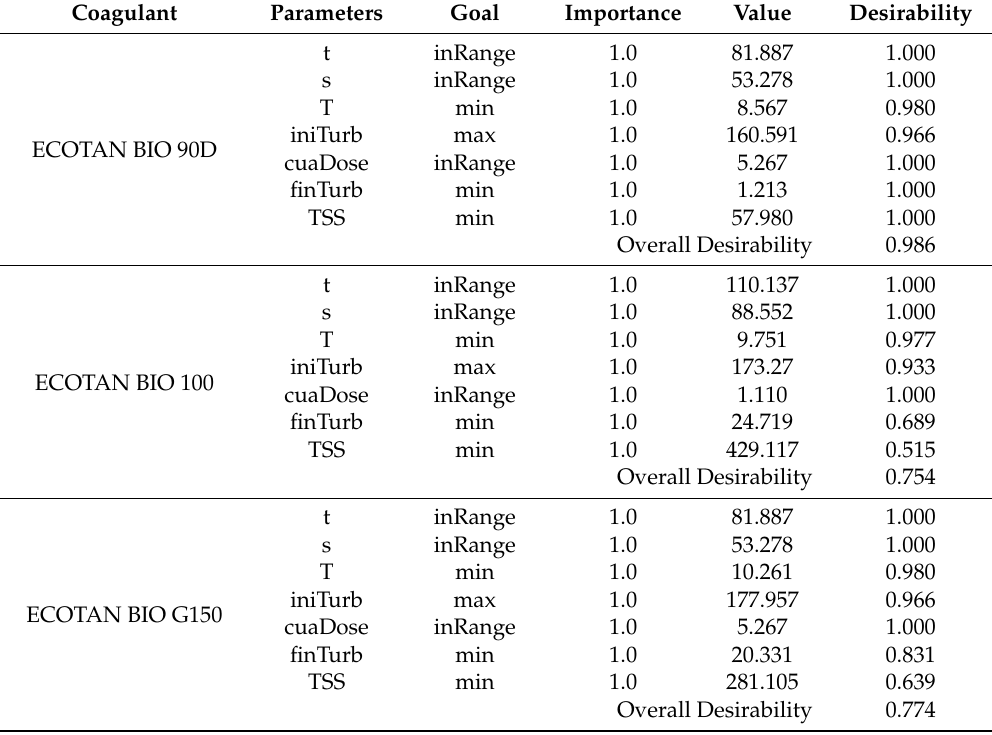
Table 17. The fourth clarification optimization scenario: the turbidity and TSS are minimized when sample water is very cold and